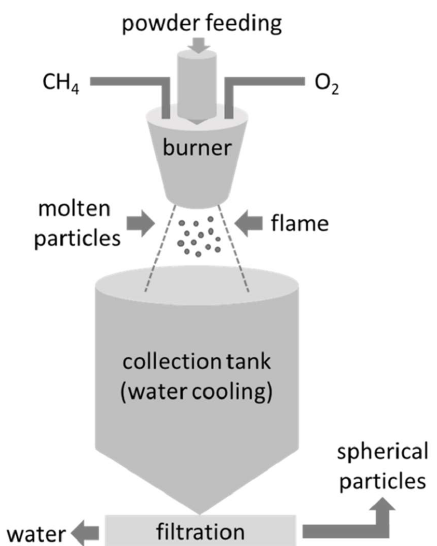
Figure 2. The schematic of preparing spherical LC particles by flame